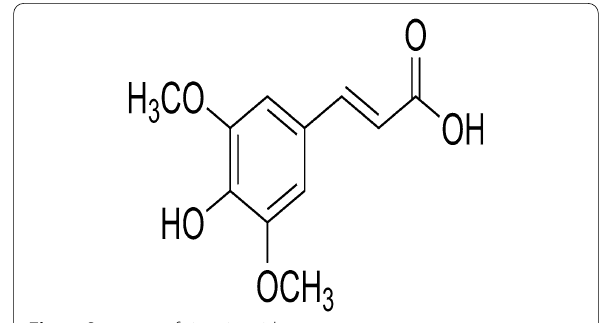
Fig. 1 Structure of sinapic